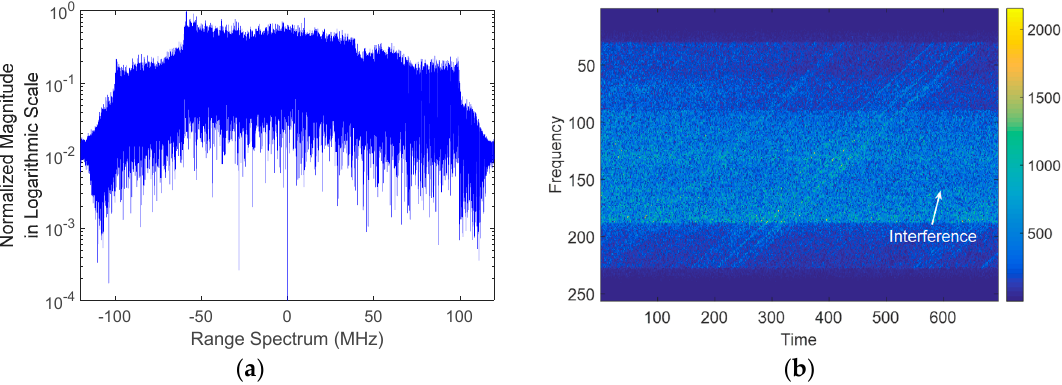
Figure 10. Illustration of broadband noise like in frequency spectra ( a ) and ( b ) its spectrogram.